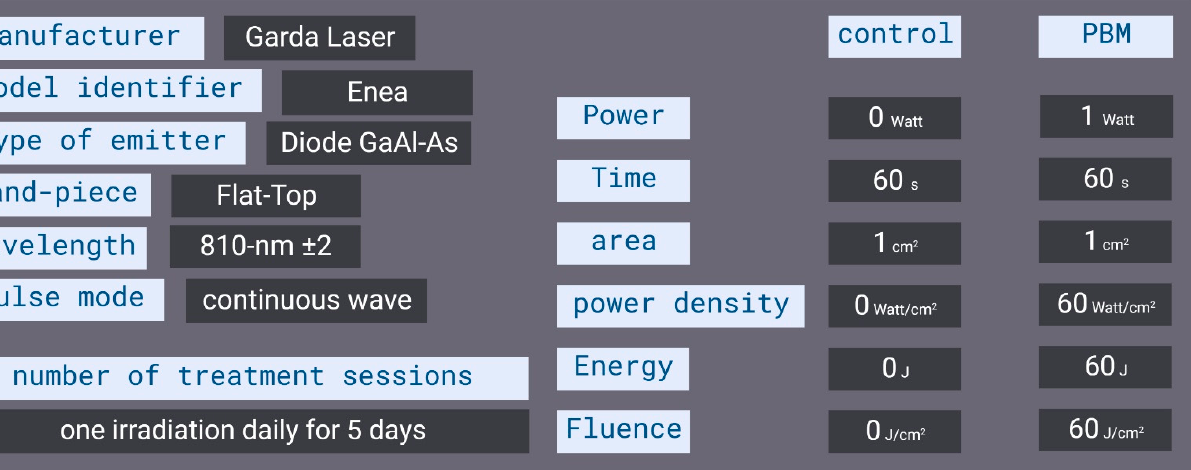
Figure 8. Outline of the PBM treatment parameters used.